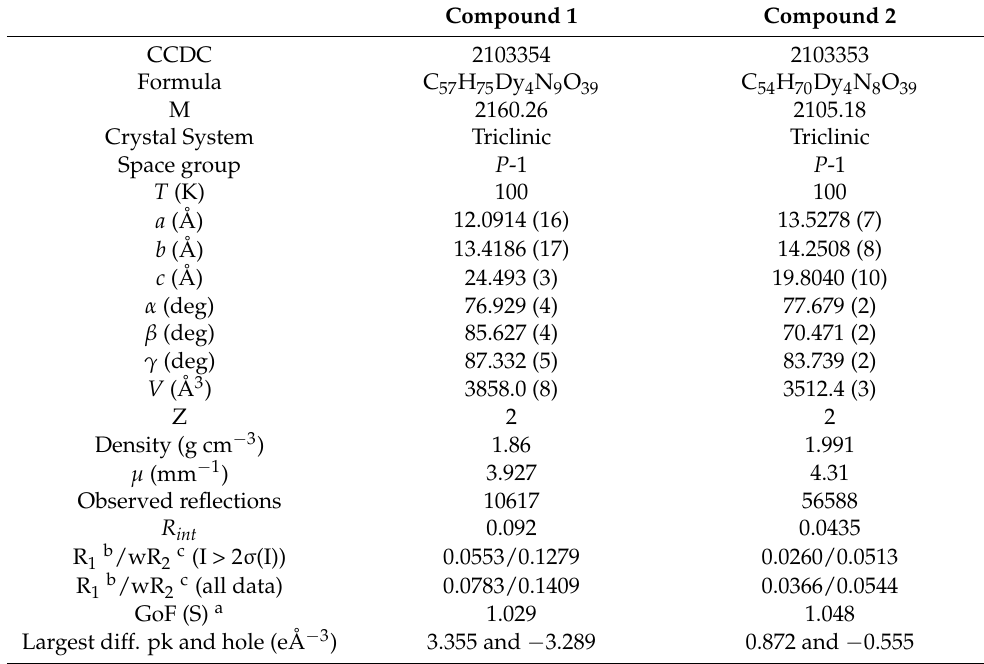
Table 1. Crystallographic data and structure refinement details for